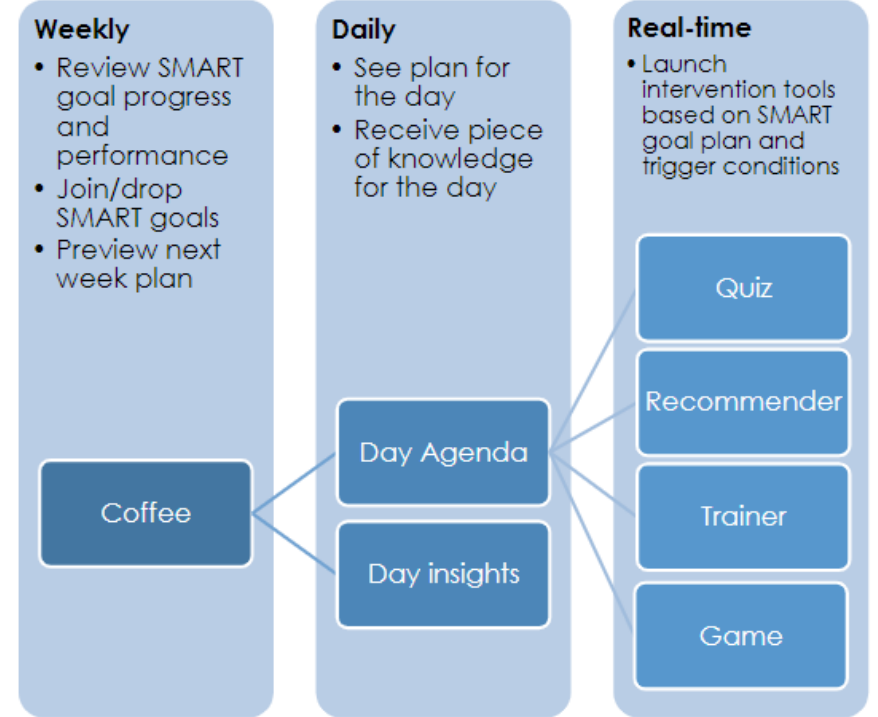
Figure 9. Coaching intervention tools in different